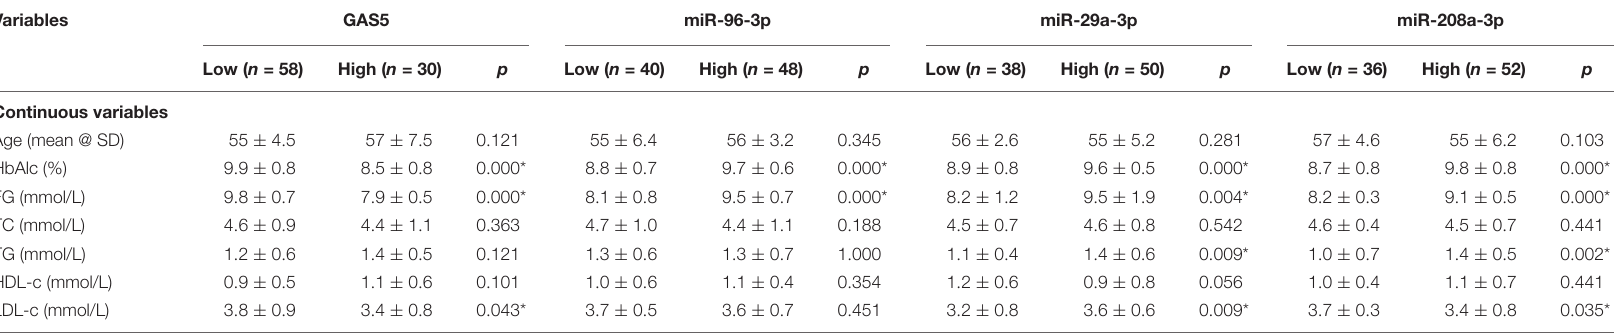
TABLE 2 | The association of GAS5, miR-96-3p, miR-29a-3p, and miR-208a-3p with continuous variables of patients with T2DM. Variables